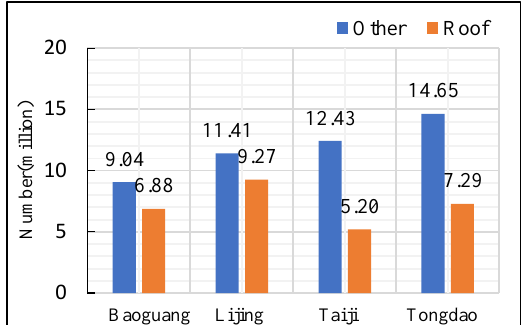
Fig5. Statistical Distribution for Roof Points of Different Scene Tab 1. Comparison Results of The Roof Extraction